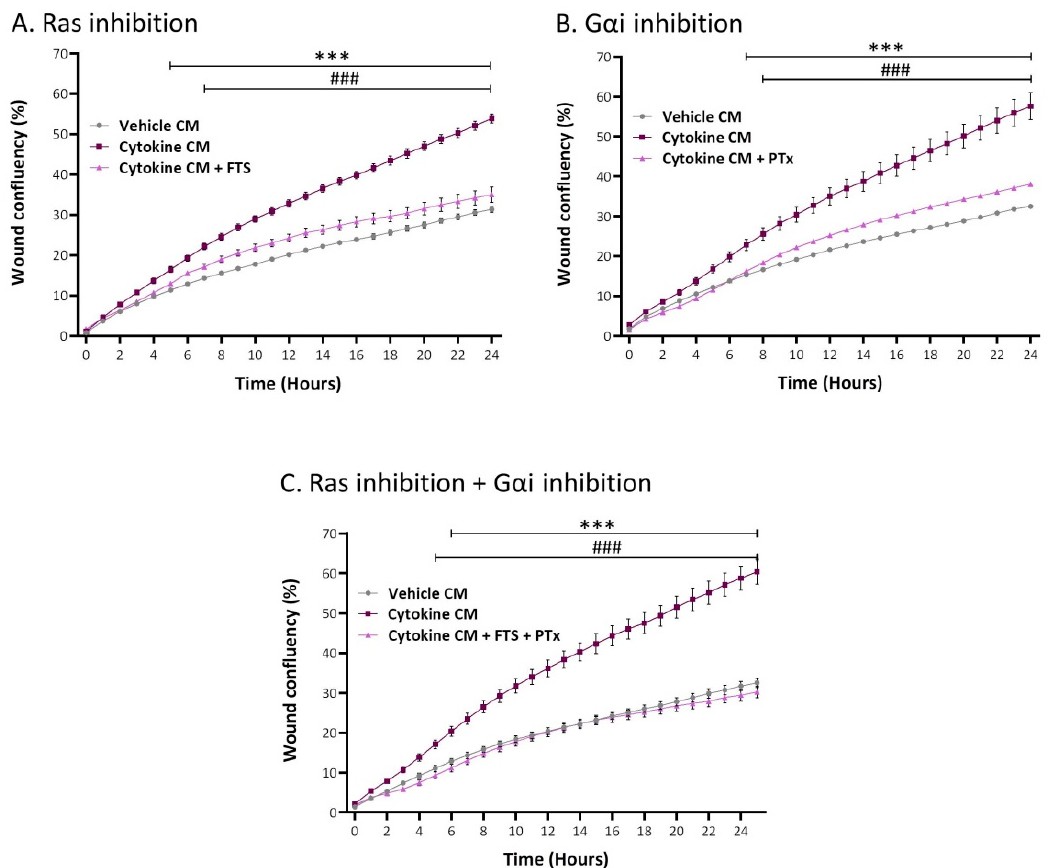
Figure 10. Tumor cell migration, elevated by inflammatory CAF-derived factors, is mediated through cooperativity between Ras-activating receptors and G protein-coupled receptors (GPCR) that signal via G α i. Human MSCs were exposed to persistent TNF α + IL-1 β stimulation (concentrations as in Figure 1) or to vehicles, generally for 14–18 days. Cytokine- devoid CM were collected as described in Figure 7 and were administered to MCF-7 cells in the presence of ( A ) FTS, an inhibitor of Ras; ( B ) PTx, an inhibitor of G α i; or ( C ) both inhibitors together. Control cells were treated by the vehicles of inhibitors. Inhibitor concentrations were selected based on the considerations described in the Materials and Methods section. Cell numbers and viability were not affected by the inhibitors. Then, kinetics analyses of wound closure assays were performed in IncuCyte ® , as described in Figure 9B. The results are presented as mean ± SEM of 8–9 replicates for each treatment. *** p < 0.001, for differences between tumor cells treated by CM of inflammation-derived CAFs and control CAFs. ### p < 0.001, for differences between tumor cells treated by the inhibitors and tumor cells that were not treated by the inhibitors. The results of a representative experiment out of n = 3 are